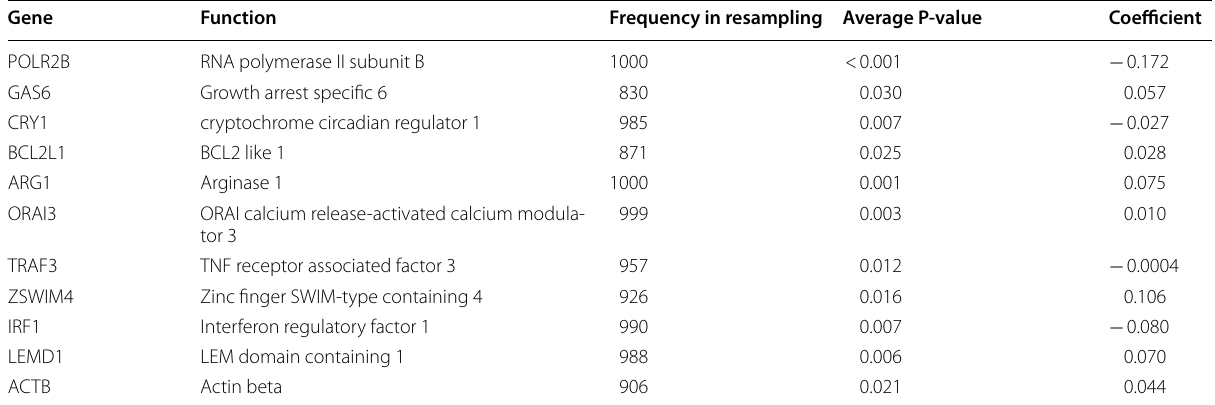
Table 1 The list of 11‑Gene fibroblastic